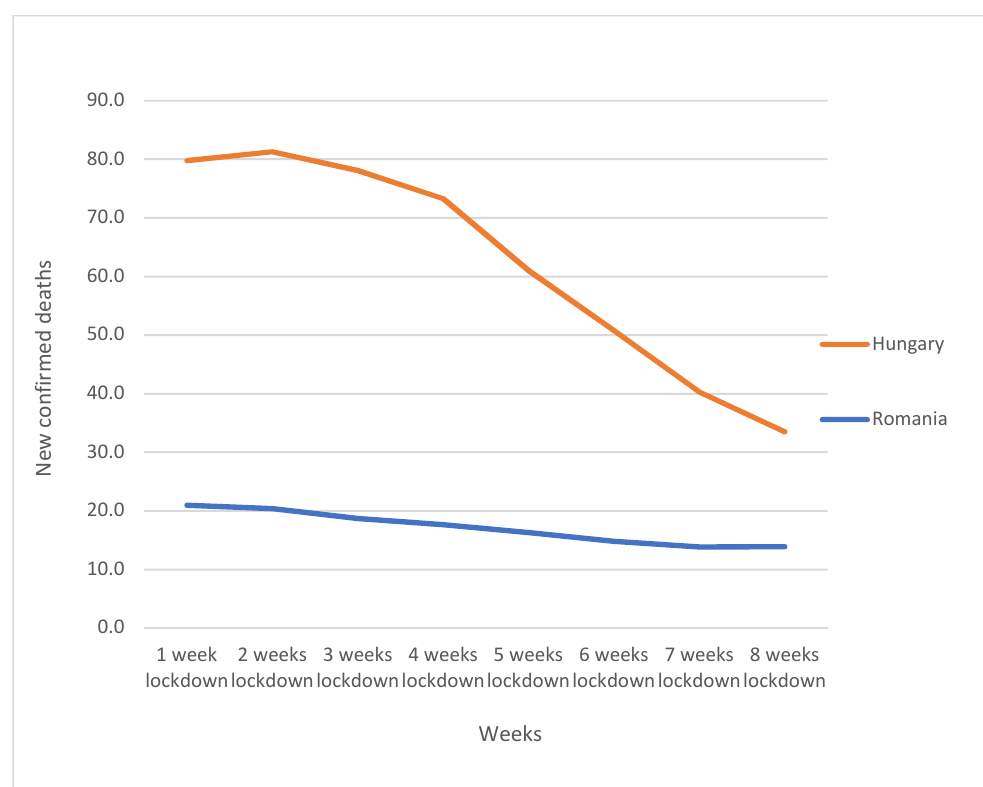
Figure 2. New confirmed COVID-19 deaths.